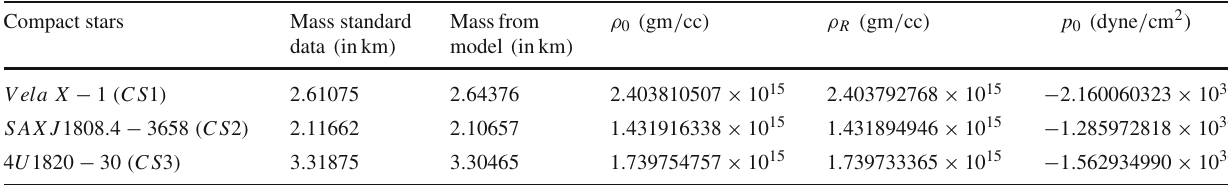
Table 6 Calculated values of mass, energy density and pressure of our model from Table 3 Compact stars Mass standard Massfrom data ( in km ) model ( in km )